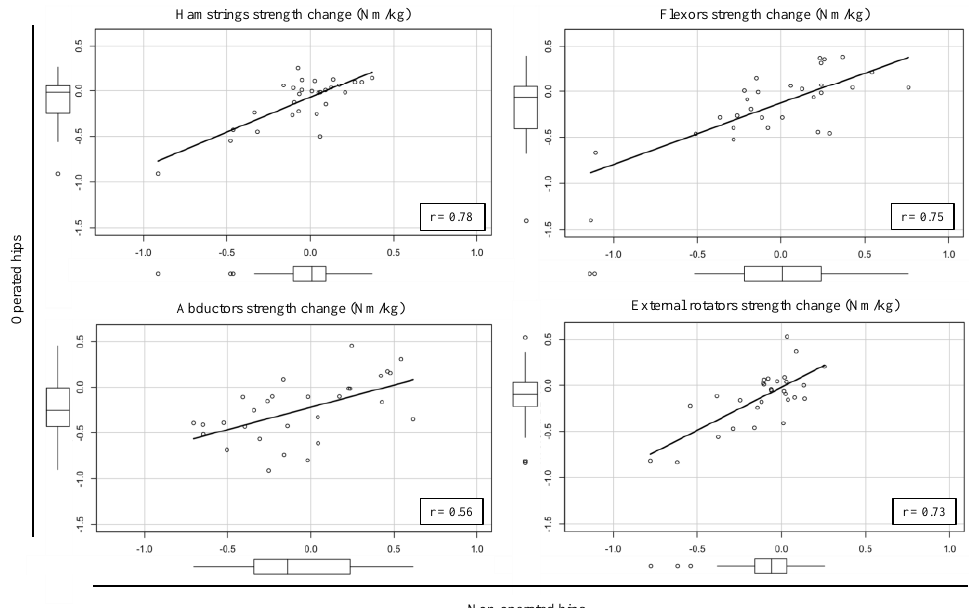
Figure 4. Correlation analysis of hip muscles strength change following surgery between the operated and non-operated